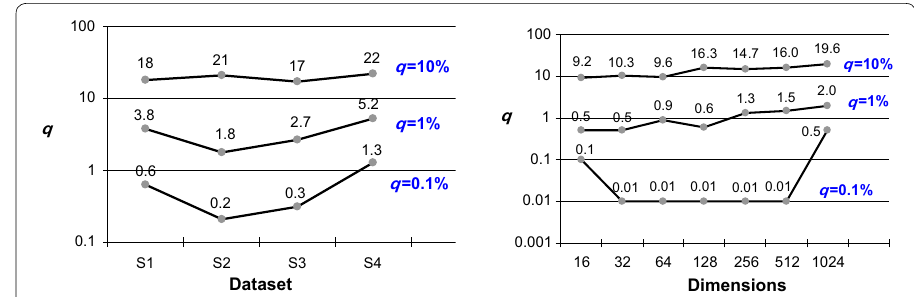
Fig. 12 Observed probability (%) of failure ( q ) for S 1 –S 4 (left) and for the high dimensional data sets (right). The observed values are plotted, and the theoretical estimates are shown as blue